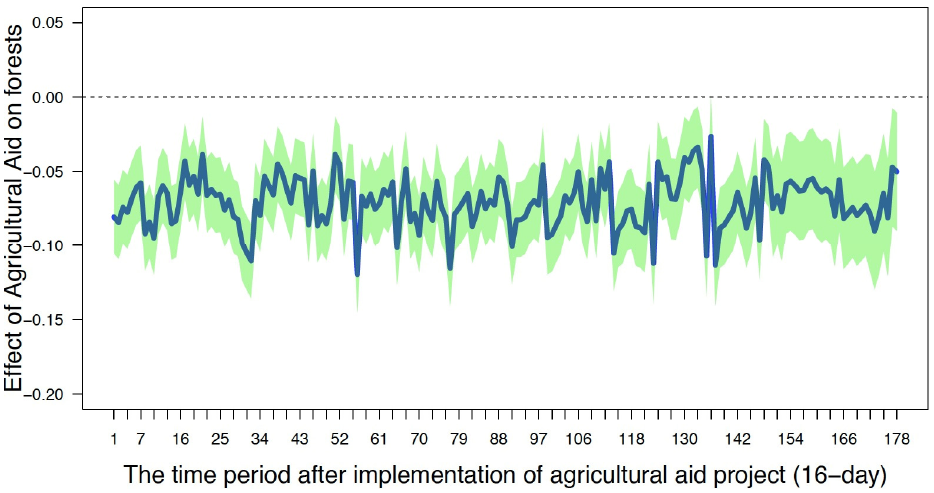
Figure 4. Causal effects of agricultural aid on sum forest NDVI across time (the shaded green areas represent the 95% confidence interval).